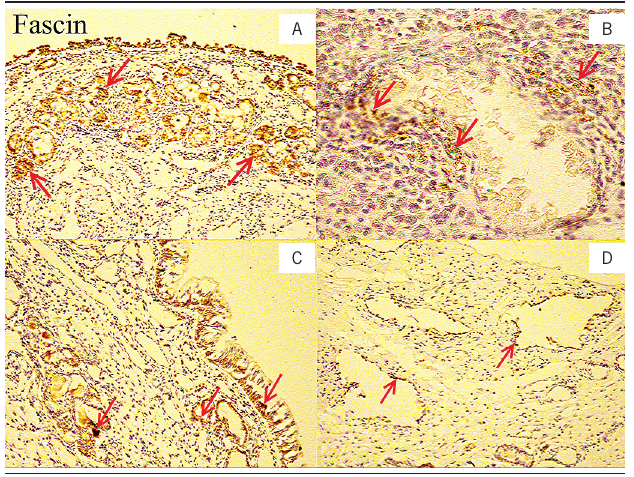
figure 1 – Nasal tissues of patients with CRSsNP and CRSwNP were immunostained with fascin antibodies A) nasal tissue of CRSsNP patient. Strong fascin expression is observed both in the epithelial layer and in the lamina propria (indentified with red arrows), 100×; B) nasal tissue of an individual with CRSsNP. A vessel is surrounded by fascin-positive cells, which are indentified with red arrows. The lamina propria is heavily infiltrated with macrophages and lymphocytes, 400×; C) polyp tissue of a CRSwNP patient. Fascin overexpression is revealed in nasal epithelial cells and in vascular walls in the lamina propria (indentified with red arrows), 100×; D) polyp tissue of a CRSwNP patient. Fascin-positive cells are in the vascular walls in the lamina propria (indentified with red arrows), 400×. CRSwNP: chronic rhinosinusitis with nasal polyps; CRSsNP: chronic rhinosinusitis without nasal